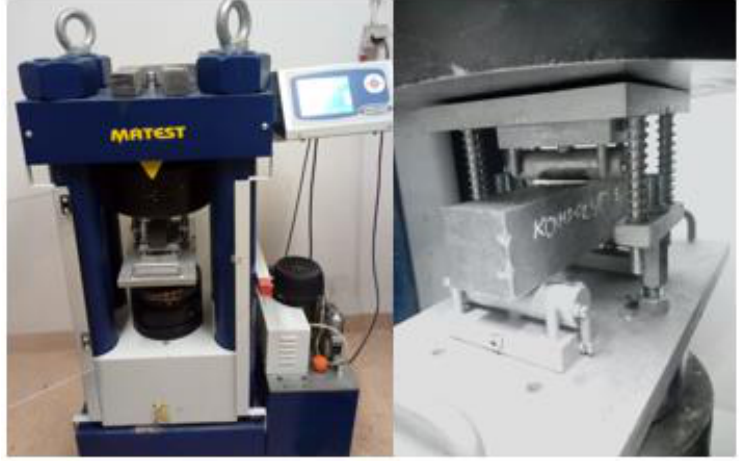
Figure 10. Flexural strength test method.